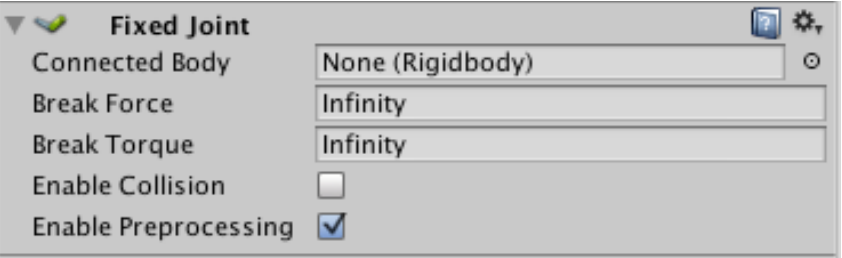
Figure 24. Illustrated operation of the “ Fixed Joint ” component. 3.6. Anchor Ropes The “ Obi Rope ” component was used to simulate anchor ropes. This component al- lowed the generation of ropes, chains, cables, etc., and allocated them the properties of the corresponding material. Figure 25 shows the properties that can be set for ropes.